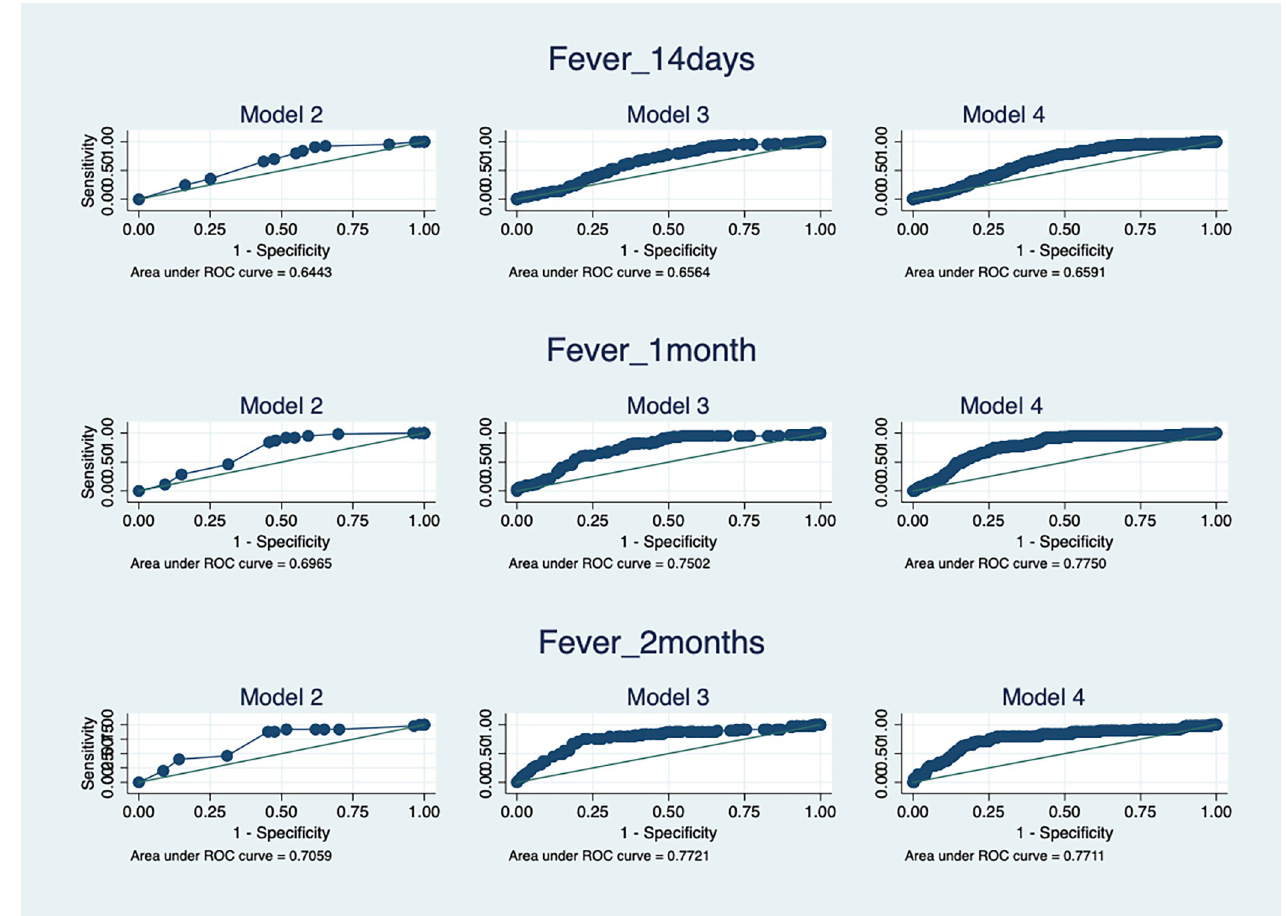
Fig 2. Receiver Operating Characteristics (ROC) for probit models of 1-month fever recall.